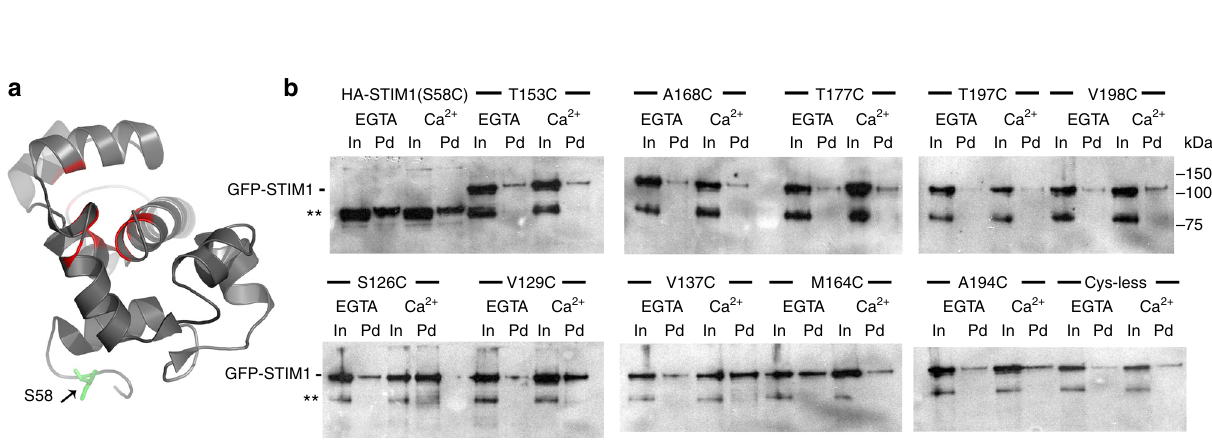
Fig. 6 Exposure of buried EFSAM cysteine residues in STIM1 is insensitive to Ca 2 + depletion. a Ribbon structure of Ca 2 + -bound EFSAM (PDB ID: 2K60). Red highlighting indicates the placement of engineered cysteine residues to probe possible EFSAM unfolding. Cysteine replacement of the fully